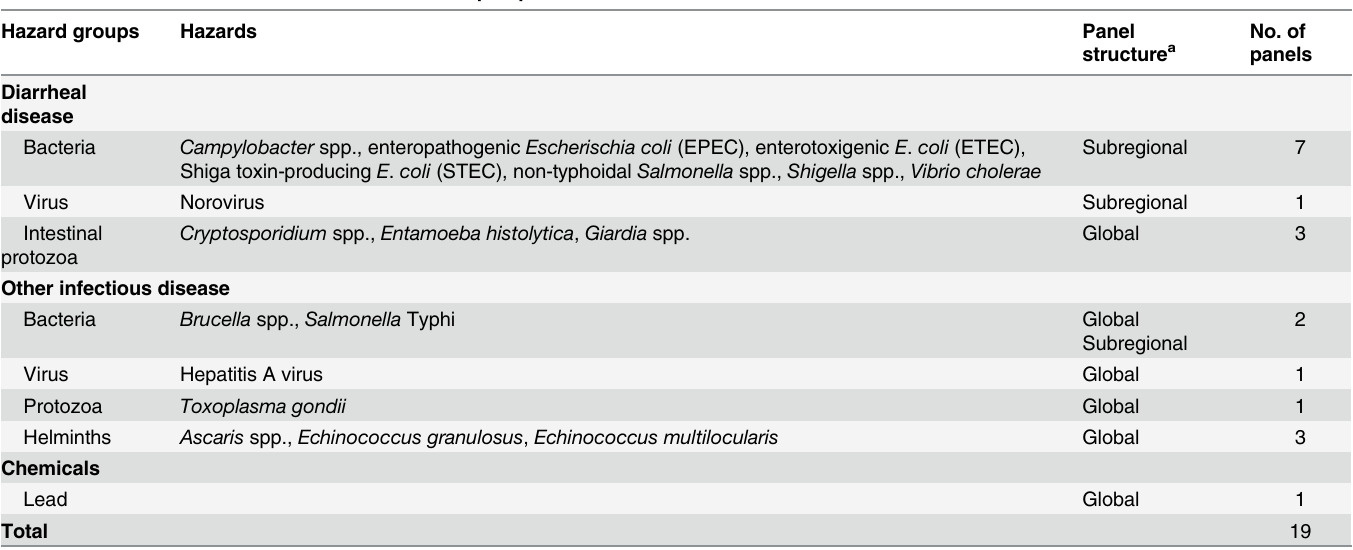
Table 1. Foodborne hazards and structure of the expert